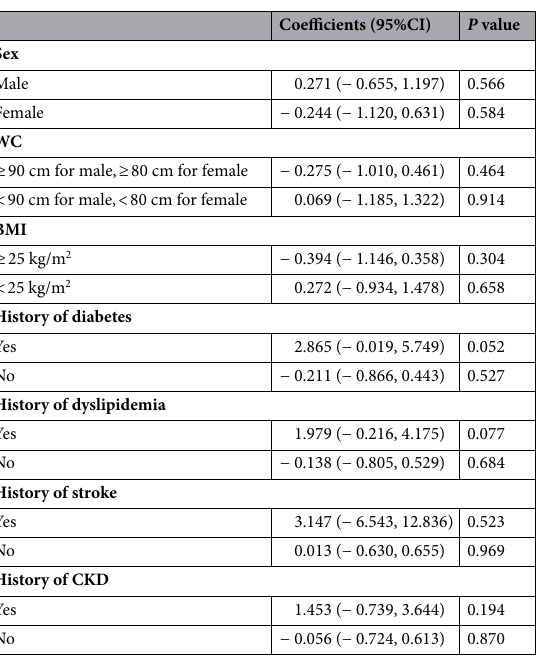
Table 5. Impact of low parental educational status and SBP in various subgroups stratified by other than age. Models were adjusted for age, sex, co-morbidities (high body mass index, high waist circumference, diabetes, dyslipidemia, coronary artery disease, stroke, and history of smoking), estimated glomerular filtration rate, proteinuria, and educational status of individual subjects. BMI, body mass index; CI, confidence interval; CKD, chronic kidney disease; WC, waist circumference.